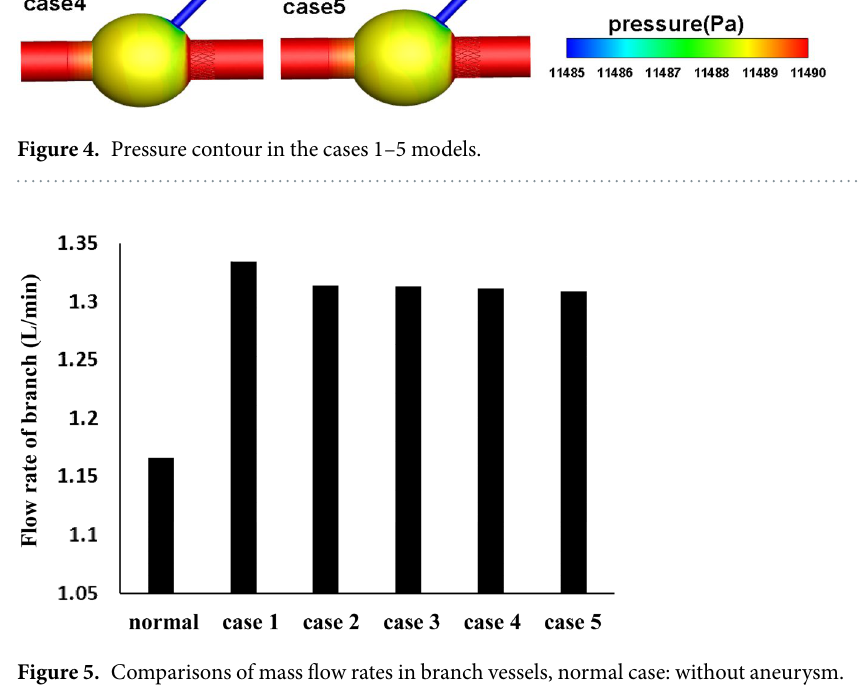
Figure 5. Comparisons of mass flow rates in branch vessels, normal case: without